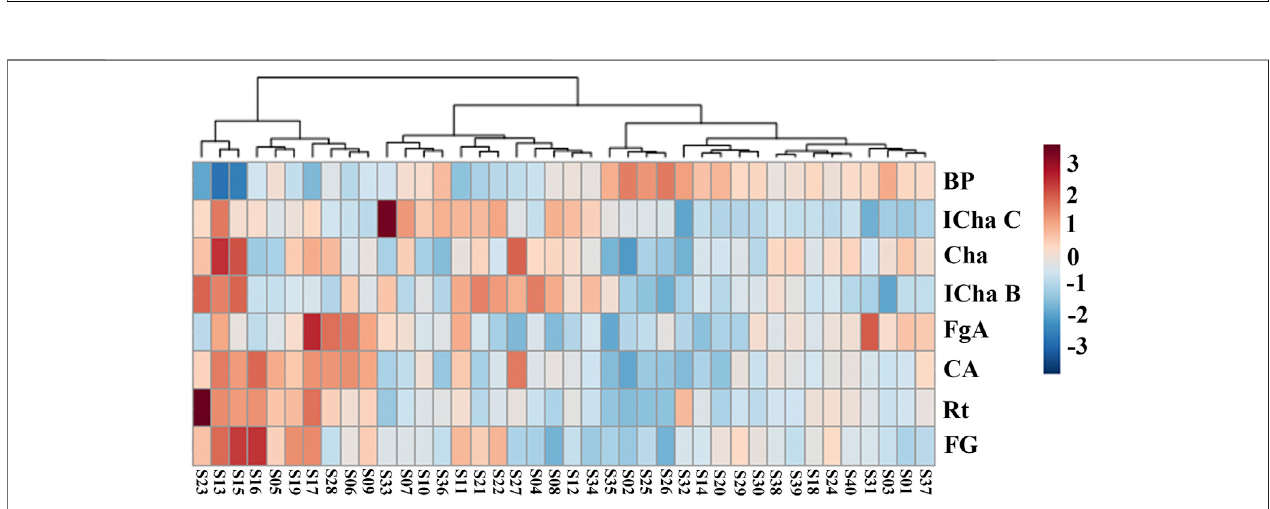
FIGURE4| Resultsoftheclusteranalysisheatmapfor40batchesofLHQWCandsevenchemicalcomponents.Intheheatmap,thegradientofdeepcolortolight color indicates high to low intensity of the content of the individual LHQWC compounds.